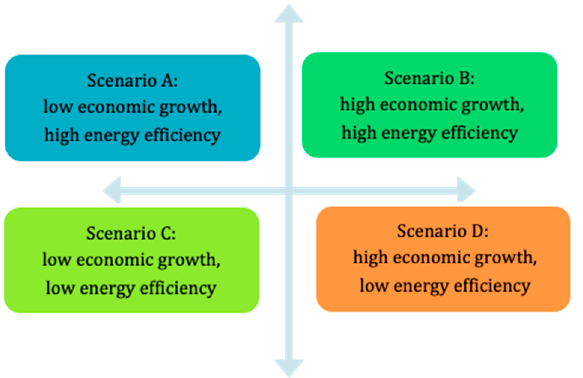
Figure 8. The proposed exploratory scenarios for the coal mining regions in Romania.